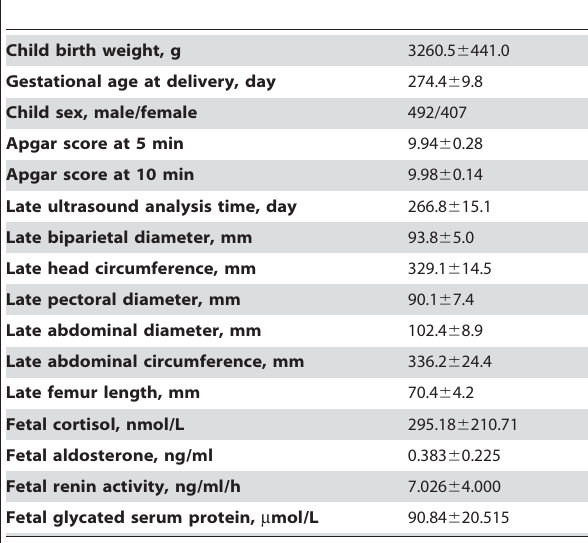
Table 2. Biometric data of the newborns (n=899) data of the newborns (n